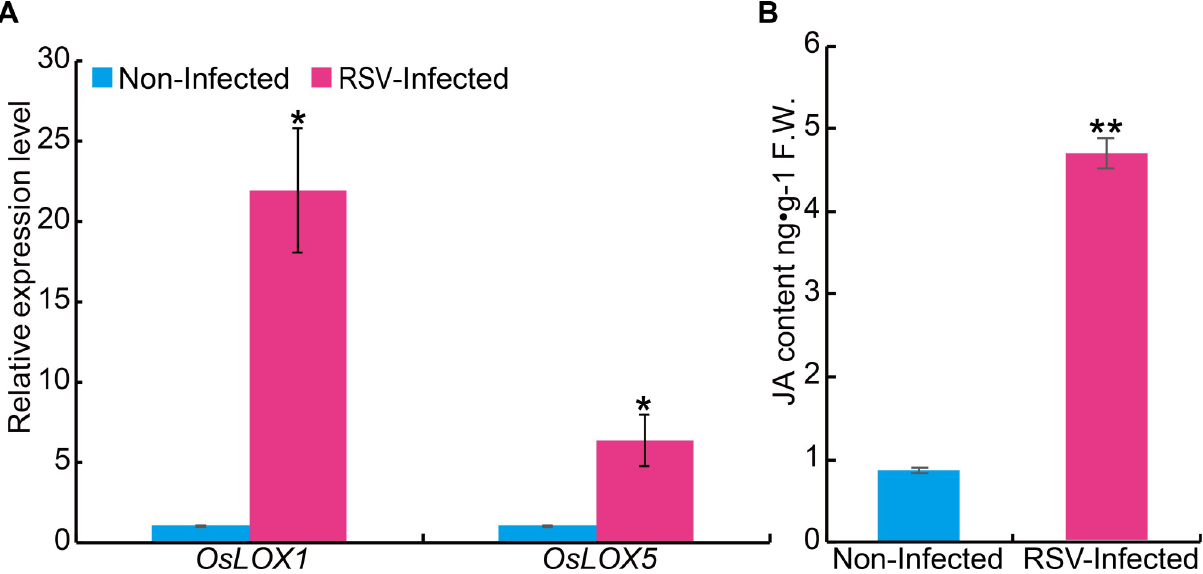
Fig 7. Expression analysis of Jasmonic acid (JA) biosynthetic genes and measurement of JA content in RSV-infected or RSV-free plants. (A) qRT– PCR assay showing the transcript levels of JA biosynthetic genes in RSV-infected and non-infected SYN rice plants. The expression level in RSV free plants was set as 1. (B) Levels of endogenous JA in RSV-infected and non-infected rice seedlings measured by nano-LC–ESI-Q-TOF-MS. Data are shown as mean ± SEM (n = 3). � P < 0.05, �� P < 0.01 by Student’s t